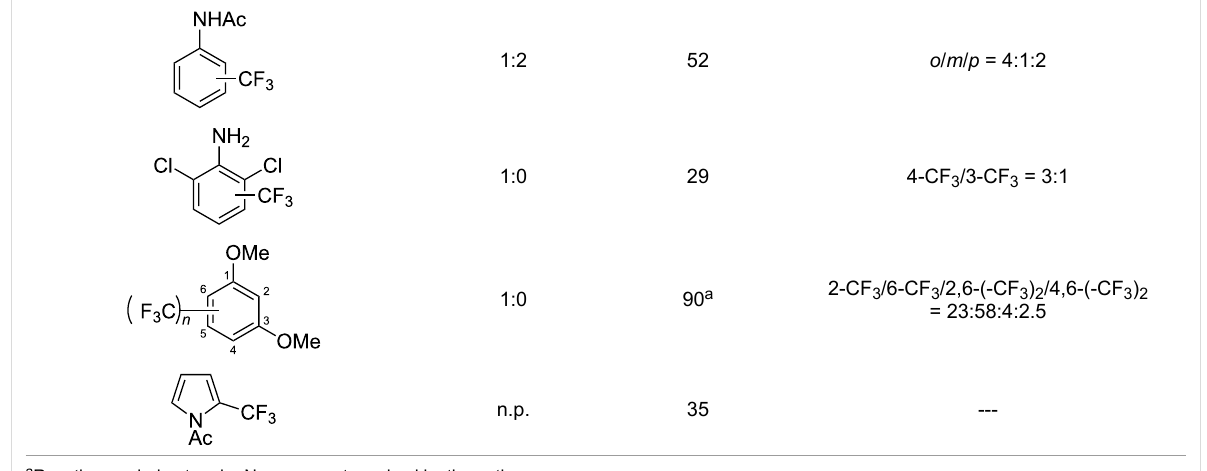
present in the CF 3 source are sufficient to initiate the reaction (Scheme